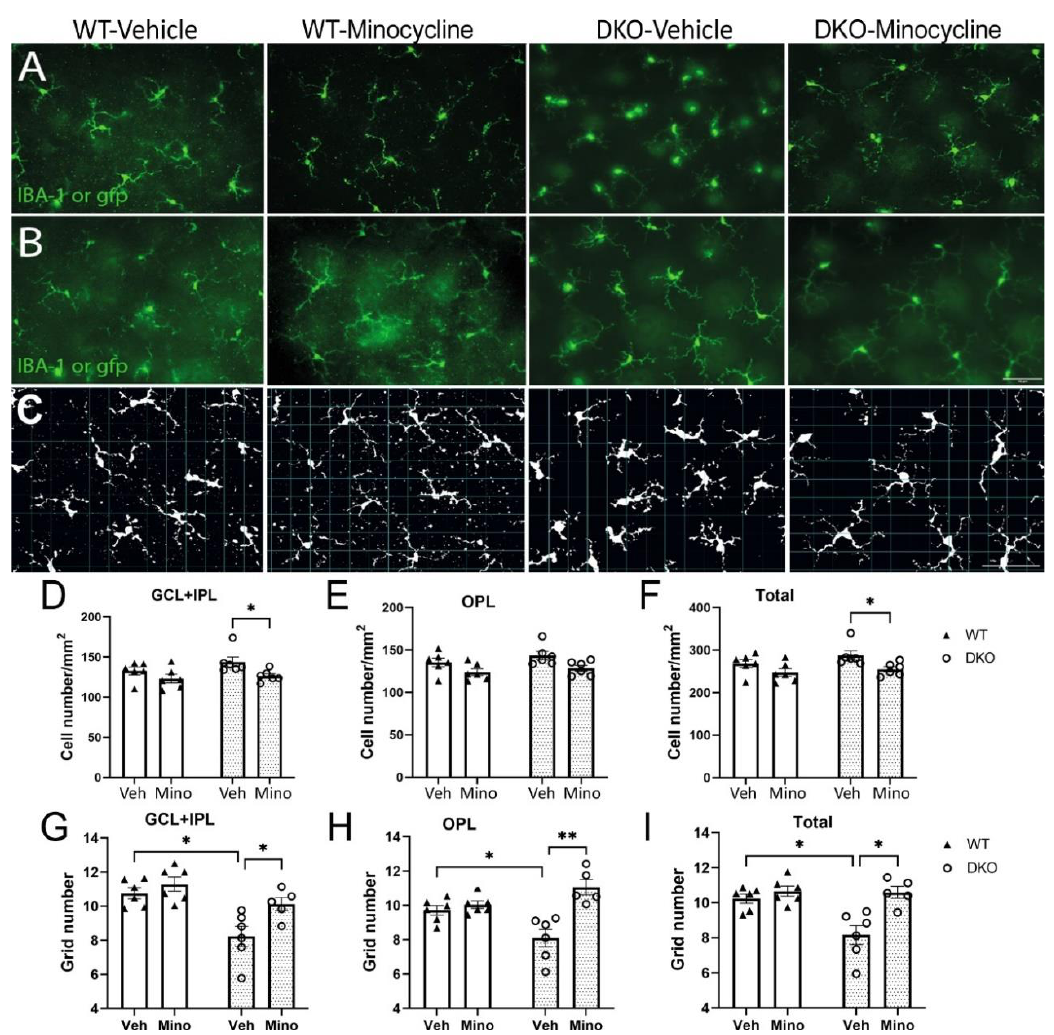
Figure 5. The effect of minocycline in retinal microglial activation. Retinal flatmounts were collected from 9-month-old wild type (WT) or double knockout (DKO) mice following 3 months vehicle or minocycline treatment, and then processed for immunostaining and confocal microscopy. WT retinas were stained for Iba-1. ( A , B ) Representative images of microglia in GCL + IPL ( A ) and OPL ( B ) from different groups. Scale bar: 50 µ m. ( C ) Representative images showing morphological evaluation of microglia from different groups using the grid system. ( D – F ) The average number of microglial cells in the GCL+ IPL ( D ), OPL ( E ) and total number of microglia ( F ) in different groups of retinas. ( G – I ) The average number of grid coverage of microglia in GCL+ IPL ( G ), OPL ( H ) or both layers ( I ) from different groups. Mean ± SEM, n = 6. * p <0.05, ** p < 0.01, by 2-way ANOVA with Sidak’s multiple comparison test. GCL: ganglion cell layer, IPL: inner plexiform layer; OPL: outer plexiform